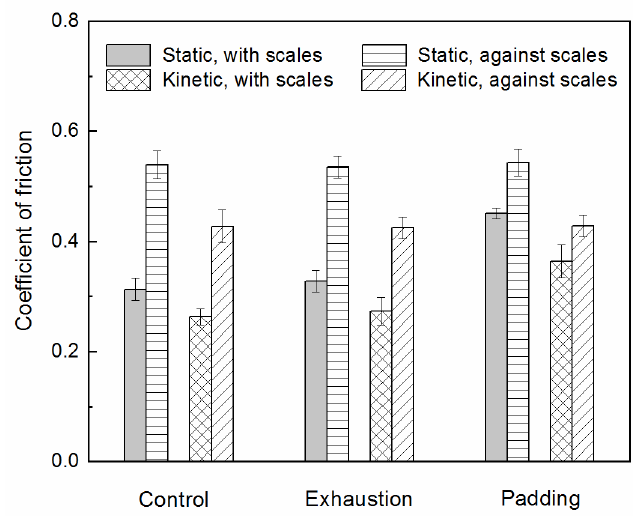
Figure 2. Effect of different treatments on friction coefficient.